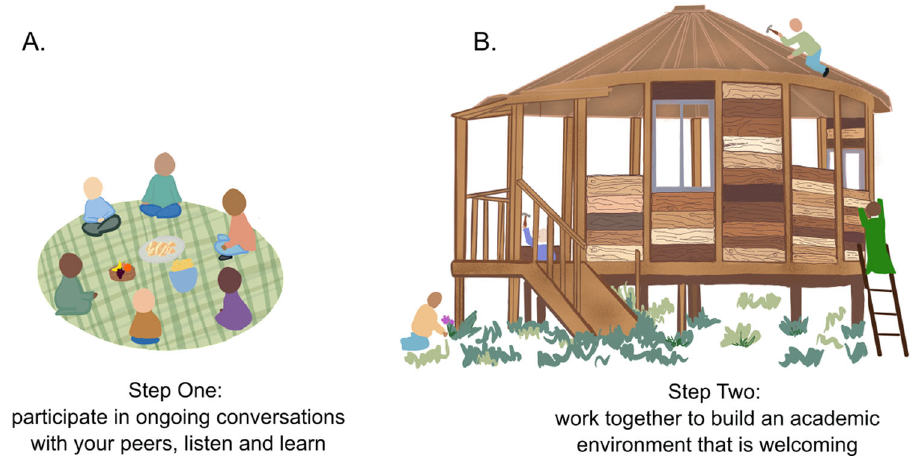
Fig. 1 A model for building an equitable environment for academics through conversation. Following our model, groups everywhere can use our course as a guide to ( A ) facilitate conversations around social justice and come to an understanding about the changes they can make to achieve racial justice and equity in academia, and ( B ) actually make those lasting changes. On the left-hand side, a diverse group of people engages in a conversation while having a picnic. On the right-hand side, a diverse group of people works together to build a home representing academia, with different colors of wooden planks, representing the many skin tones that are present in